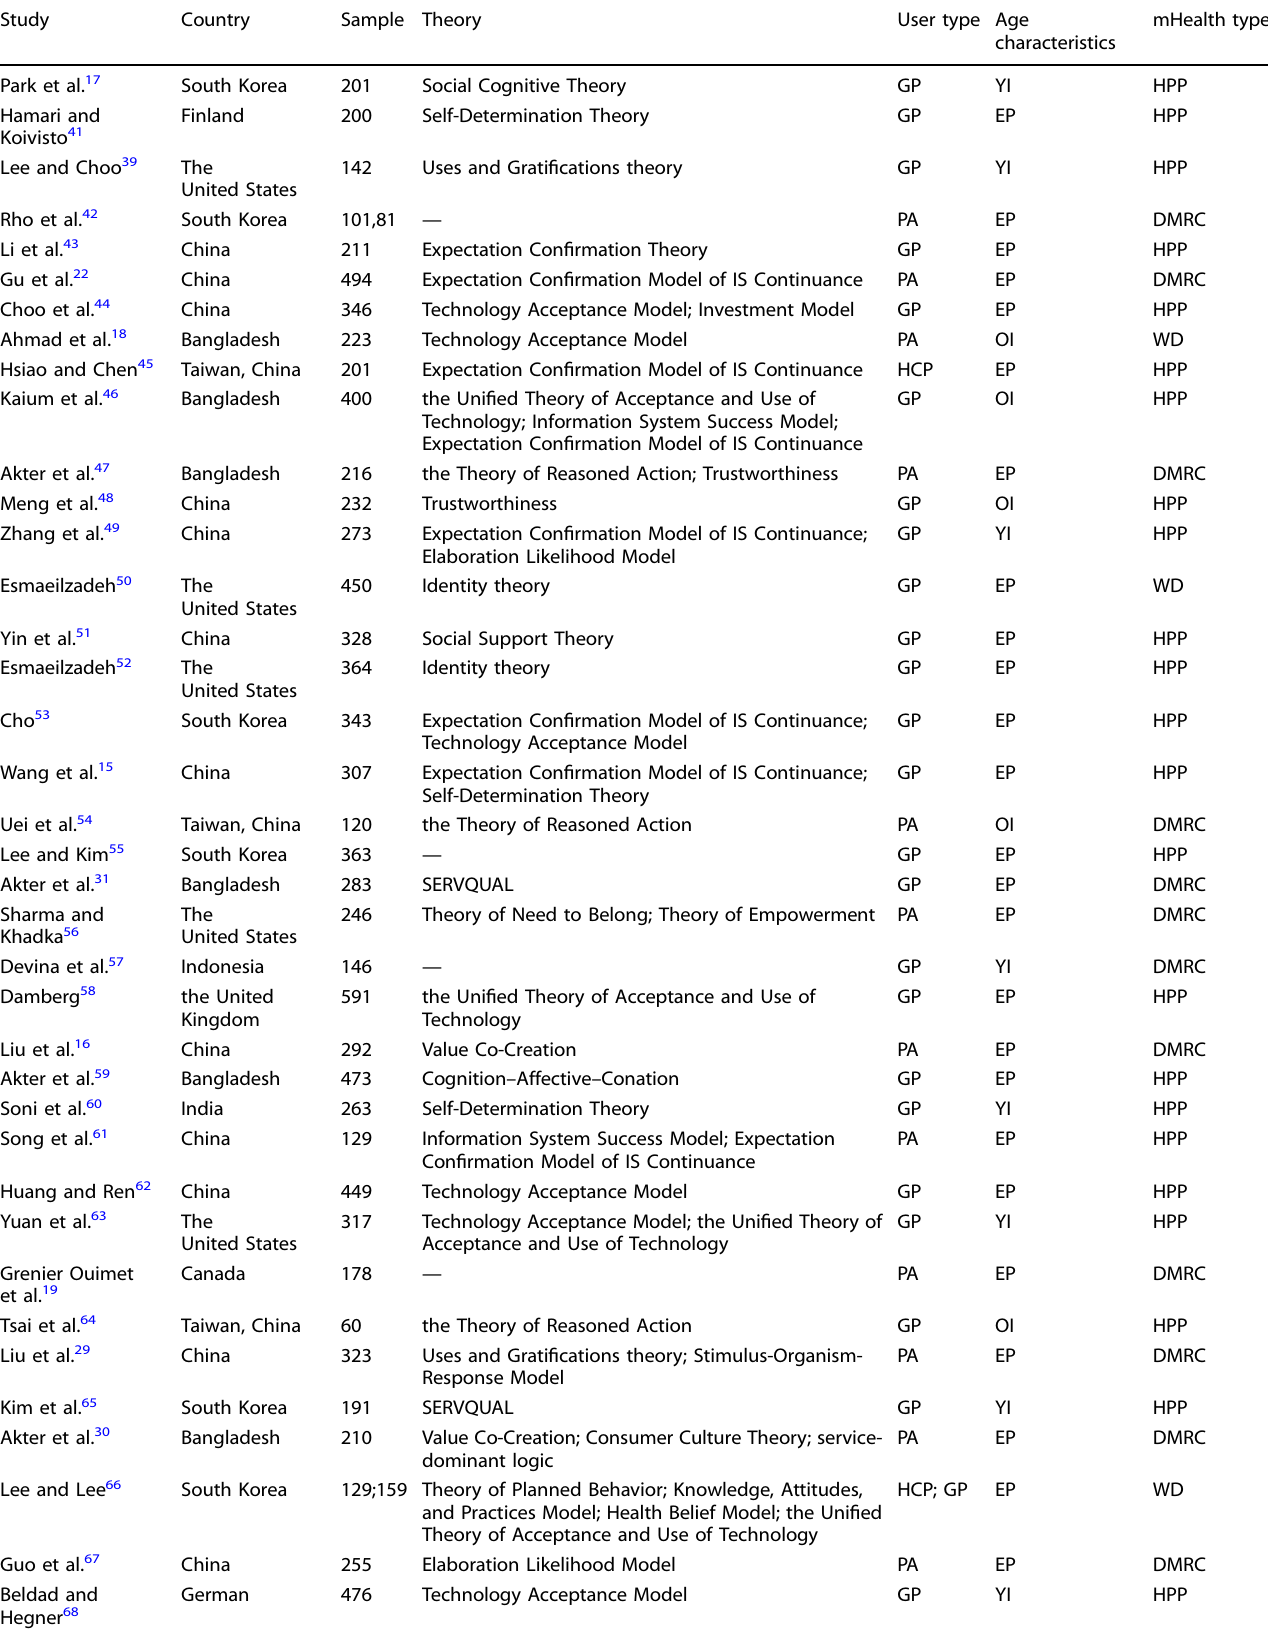
Table 1. Research studies included in